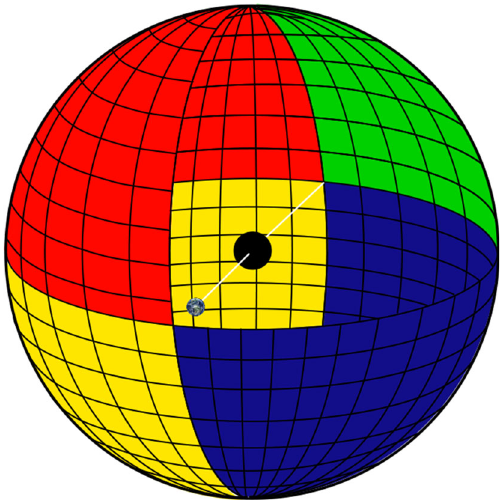
Fig. 9 Scheme of the celestial sphere where we remove a section of this to see inside the observer (Earth) and the compact object. The sphere is divided into four quadrants as follows. Top , for 0 ≤ θ < π/ 2: green quadrant, if 0 ≤ φ < π ; red quadrant, π ≤ φ < 2 π . Bottom , for π/ 2 ≤ θ < π : blue quadrant, if 0 ≤ φ < π ; yellow quadrant, if π ≤ φ < 2 π . The white line represents the direction of observation that coincide with radial direction